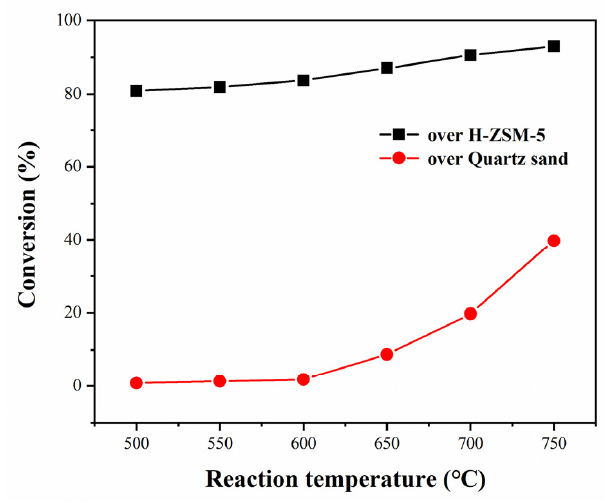
Figure 6. Conversions of pentene cracking over quartz sand and H-ZSM-5 vs. reaction temperatures. Reaction conditions: total pressure, 130 kPa; partial pressure, 60 kPa; WHSV, 83 h − 1 .